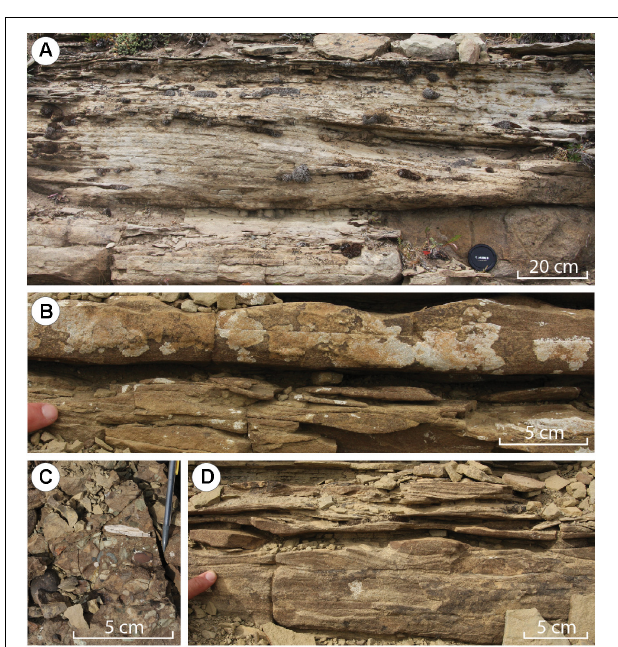
FIGURE 9 | Figueroa basin margin topset facies. (A) Hummocky cross-stratified (HCS) fine-grained sandstone (F9). (B) Symmetrical (top) and asymmetrical ripples (below) within fine-grained sandstone deposits (F9). (C) Coarse-grained sandstone with pebbles, granules, shell material, and woody debris (F7). (D) Planar laminae overlain by asymmetrical ripples in fine-grained sandstone deposits (F13). All outcrop locations are denoted by figure number within Figures 2C,E , 3